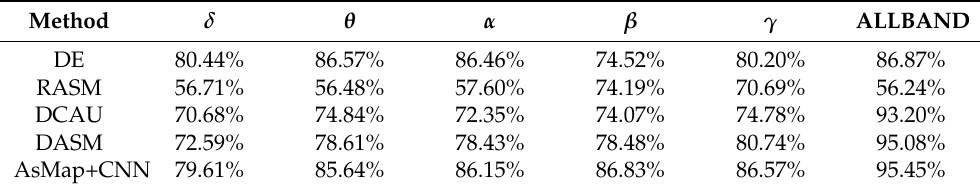
Table 2. Valence classification accuracy obtained using different feature extraction techniques on frequency bands.